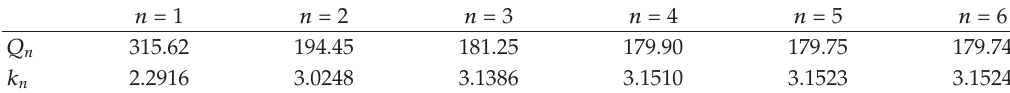
Table 4: The iterative method of Wu and Ouyang (cid:4) 1 (cid:5)